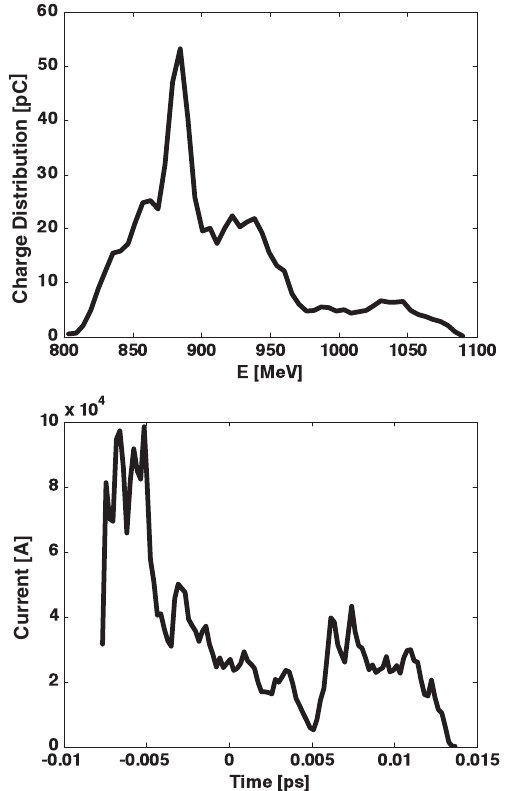
FIG. 1. Charge distribution vs energy (top) and current vs time (bottom) of the initial electron distribution as obtained with the PIC code ALADYN